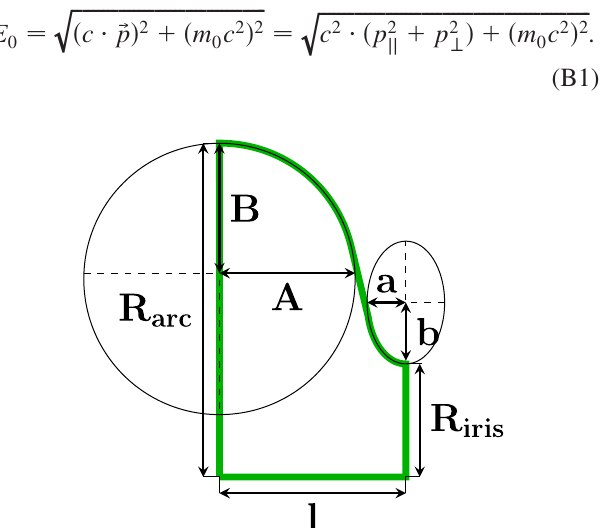
FIG. 35. Cavity with labels of the shape parameters used in Table